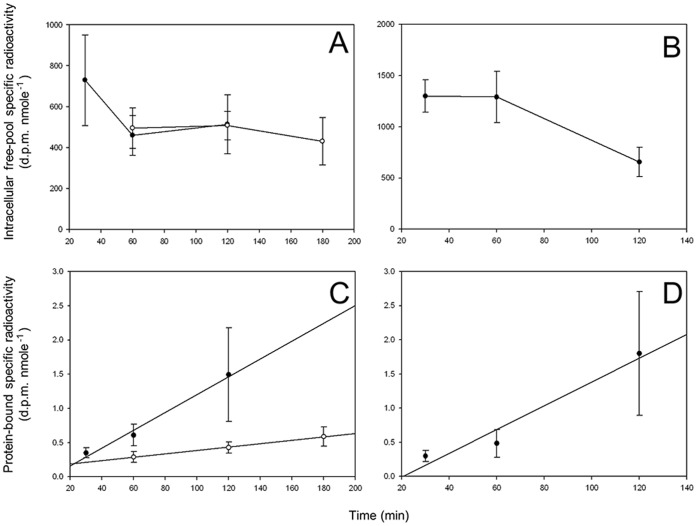
Validation of the flooding dose technique for use in gammarid amphipods.(A) Intracellular free-pool specific radioactivities for phenylalanine in G. oceanicus from Svalbard (79°N) held at 5°C (open circles; n = 6) and G. oceanicus from Scotland (58°N) held at 13°C (closed circles; n = 5). (B) Intracellular free-pool specific radioactivities for phenylalanine in G. duebeni from Scotland held at 13°C (n = 8). (C) The relationship between protein-bound specific radioactivities of phenylalanine and time in G. oceanicus from Svalbard held at 5°C (open circles; n = 6) and G. oceanicus from Scotland held at 13°C (closed circles; n = 5). (D) The relationship between protein-bound specific radioactivities of phenylalanine and time in G. duebeni from Scotland held at 13°C (n = 8). All values are means ±SEM. The equations for the linear regression lines in C and D are given in Table 2. All regression lines were highly significant and the intercepts were not significantly different to zero.